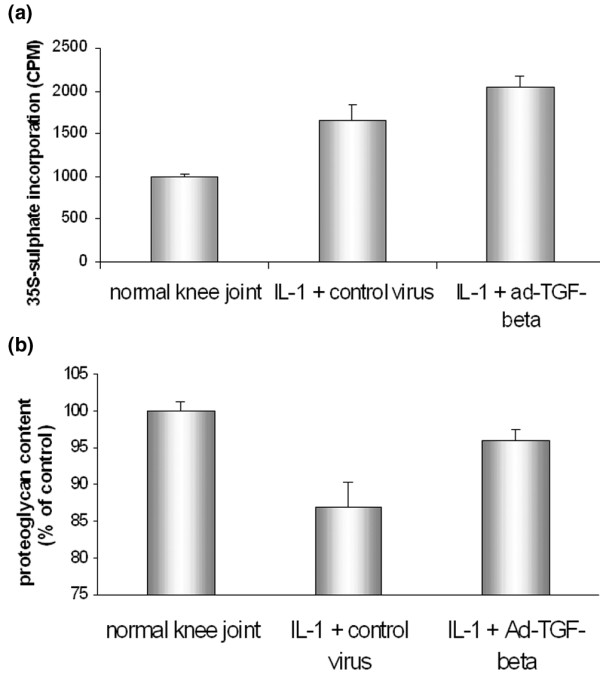
Effect of adenoviral transforming growth factor-β (TGF-β) expression on proteoglycan (PG) synthesis and content in cartilage. (a) PG synthesis was measured by 35SO42- incorporation into patellar cartilage 4 days after interleukin-1 (IL-1) injection. (CPM = counts per minute) PG synthesis increased after IL-1 injection (p < 0.005), and this increase was boosted by TGF-β (p < 0.0005 compared with IL-1). (b) PG content of cartilage was measured by Safranin O staining intensity of the cartilage in Safranin O/Fast Green stained sections. The mean PG content of non-treated knee joints was set at 100%. After IL-1 exposure, a clear reduction in PG content was observed (p < 0.05). By adenoviral expression of TGF-β after IL-1-induced damage, the PG content of the cartilage was almost normal. Error bars display standard error.